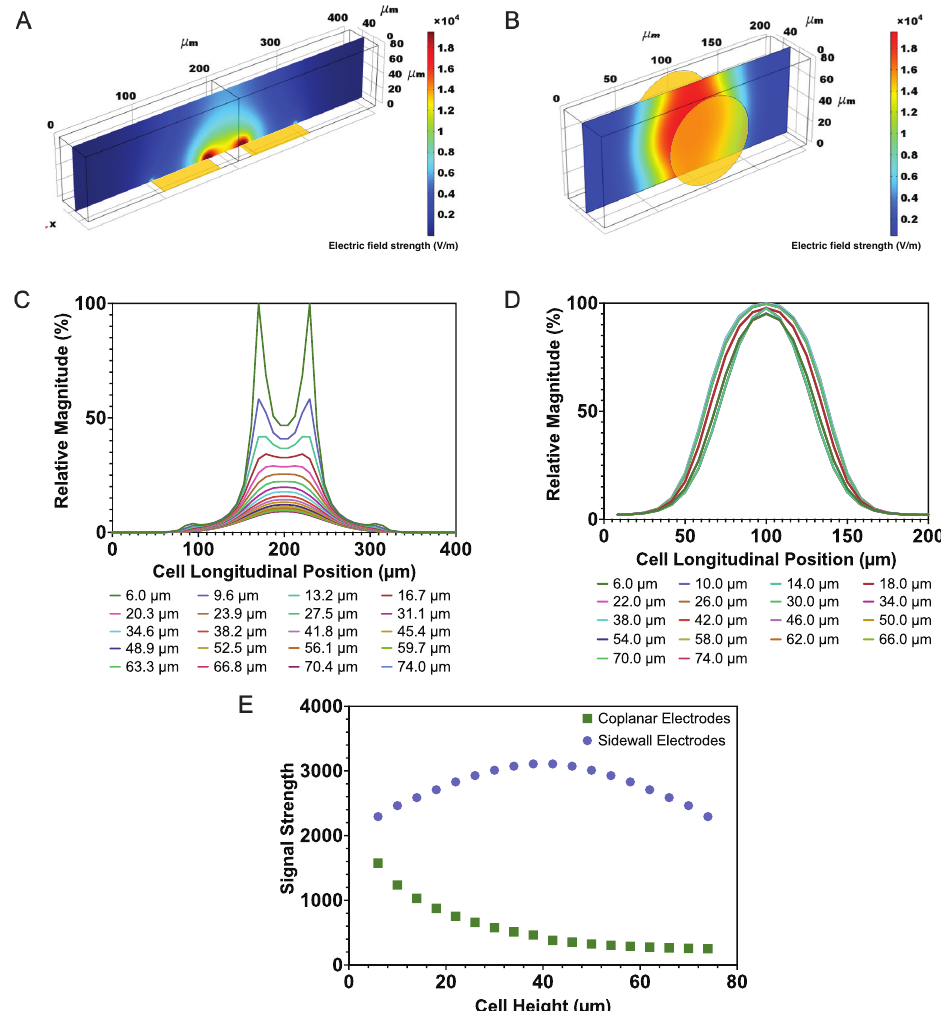
Figure 2. ( A ) Map of the electric field strength through the microfluidic channel centerline created by coplanar electrode geometry, ( B ) map of electric field strength through the microchannel centerline created by parallel electrode geometry, ( C ) relative impedance magnitude variation (%) of insulating sphere passing between coplanar electrodes, ( D ) relative impedance magnitude variation (%) of insulat- ing sphere passing between parallel electrodes, and ( E ) areas under the curves corresponding to each impedance magnitude profile from both electrode geometries. Each plot line corresponds to a pathway through the channel at the longitudinal centerline at various heights ranging from the top to the bottom of the microchannel. Cell heights and Z values refer to positions of the center of the insulating